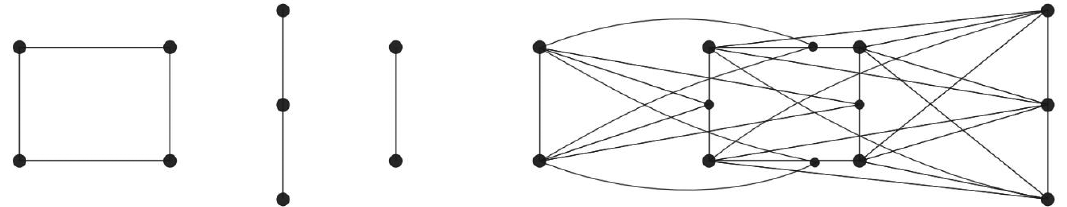
Figure 1: The SVE-join of